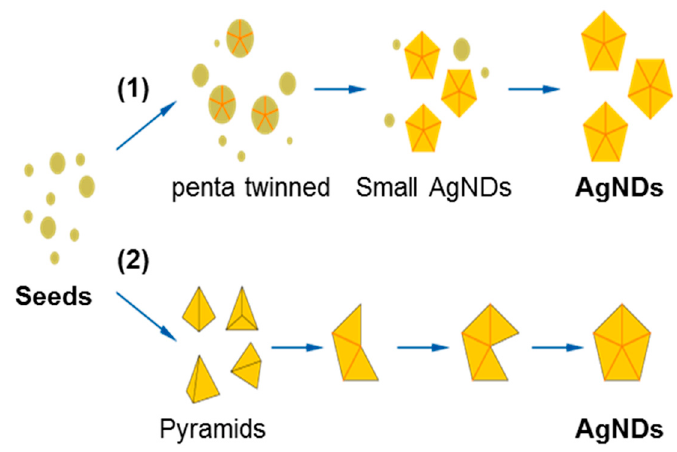
Figure 4. Proposed mechanisms of formation of AgNDs.